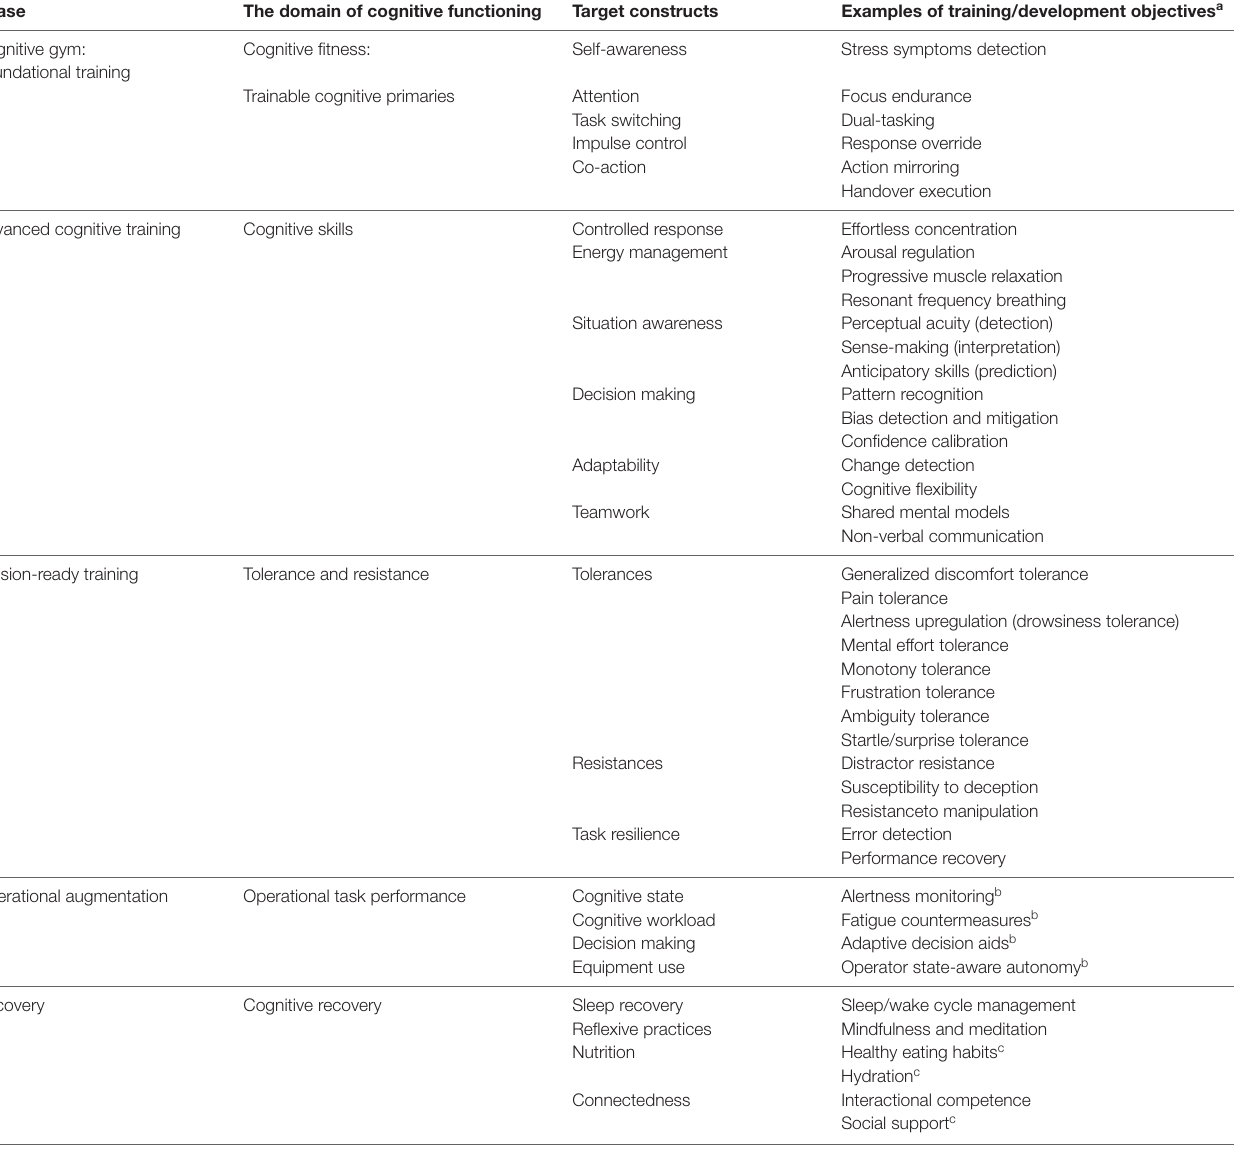
TABLE 1 | Phases of cognitive fitness (CF) cycle: from training to operational performance and